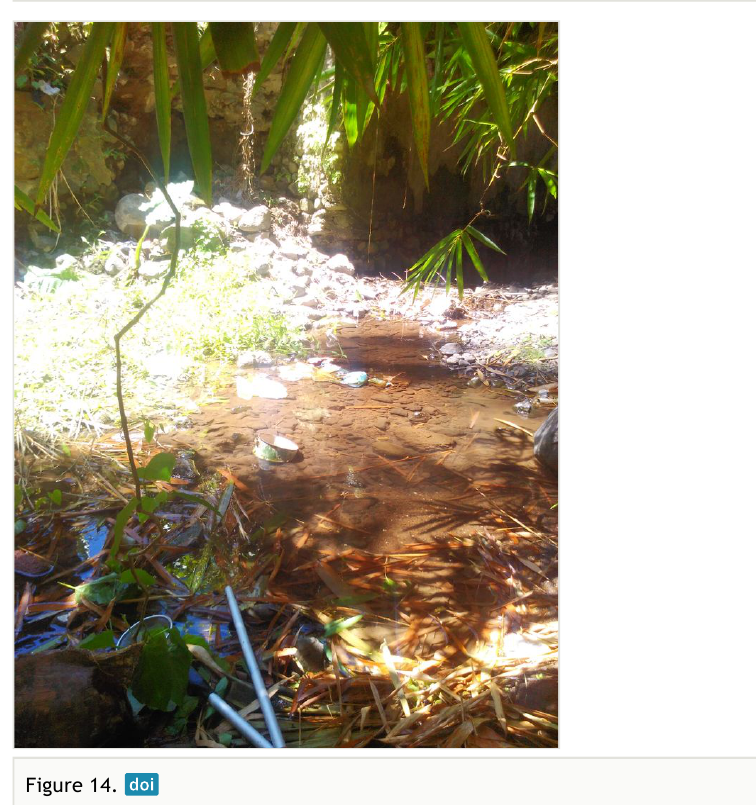
Collecting site